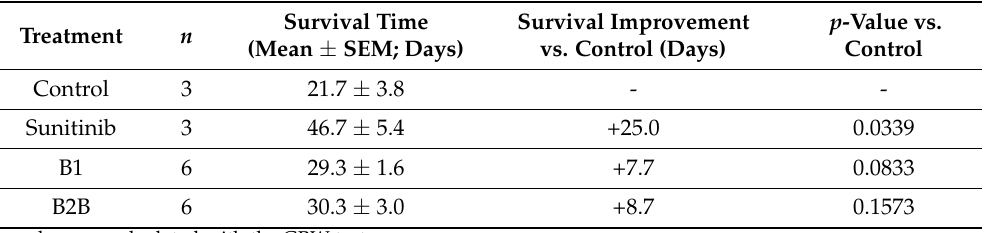
Figure 1. Anticancer activity of several artificial diets, capecitabine and cisplatin in mice with peritoneally disseminated ovarian cancer (ID8 Trp53 − / − murine ovarian cancer cells inoculated in the peritoneum of immunocompetent C57BL/6JRj mice). ( a ) Survival of untreated mice (control), mice treated with oral capecitabine (450 mg/kg/day, 7/7 schedule, 3 cycles), mice treated with cisplatin (intraperitoneal administration of 5 mg/kg once a week for 4 weeks) and mice treated with diets TC5, B1 and B2B for 6 weeks (normal diet was replaced by one of these diets). ( b ) Body weights of the mice (mean percentage ± SEM) relative to body weights at the beginning of treatments (day 14). Table 2. Survival of mice with peritoneally disseminated renal cell carcinoma treated with sunitinib and diets B1 and